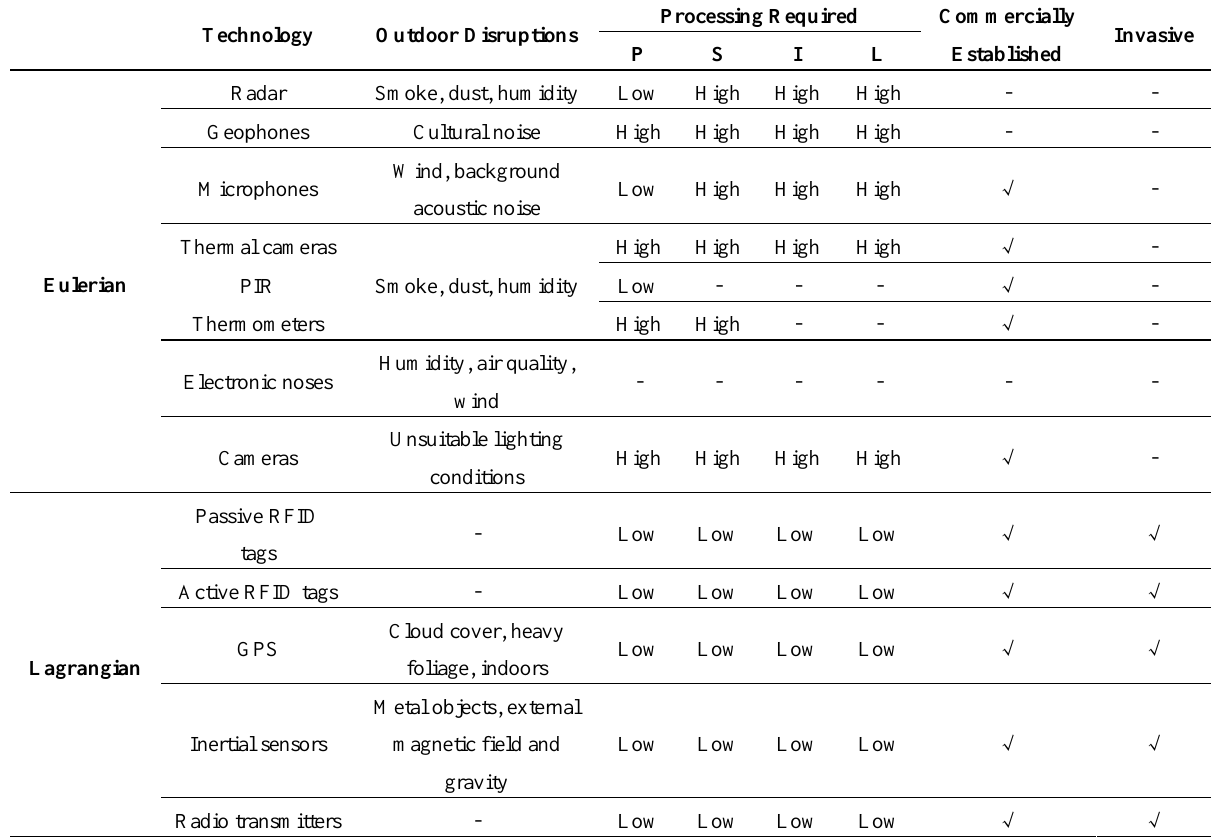
Table 2. Comparison of sensing technologies based on a number of performance metrics. P (presence), I (Identity), S (species type), L